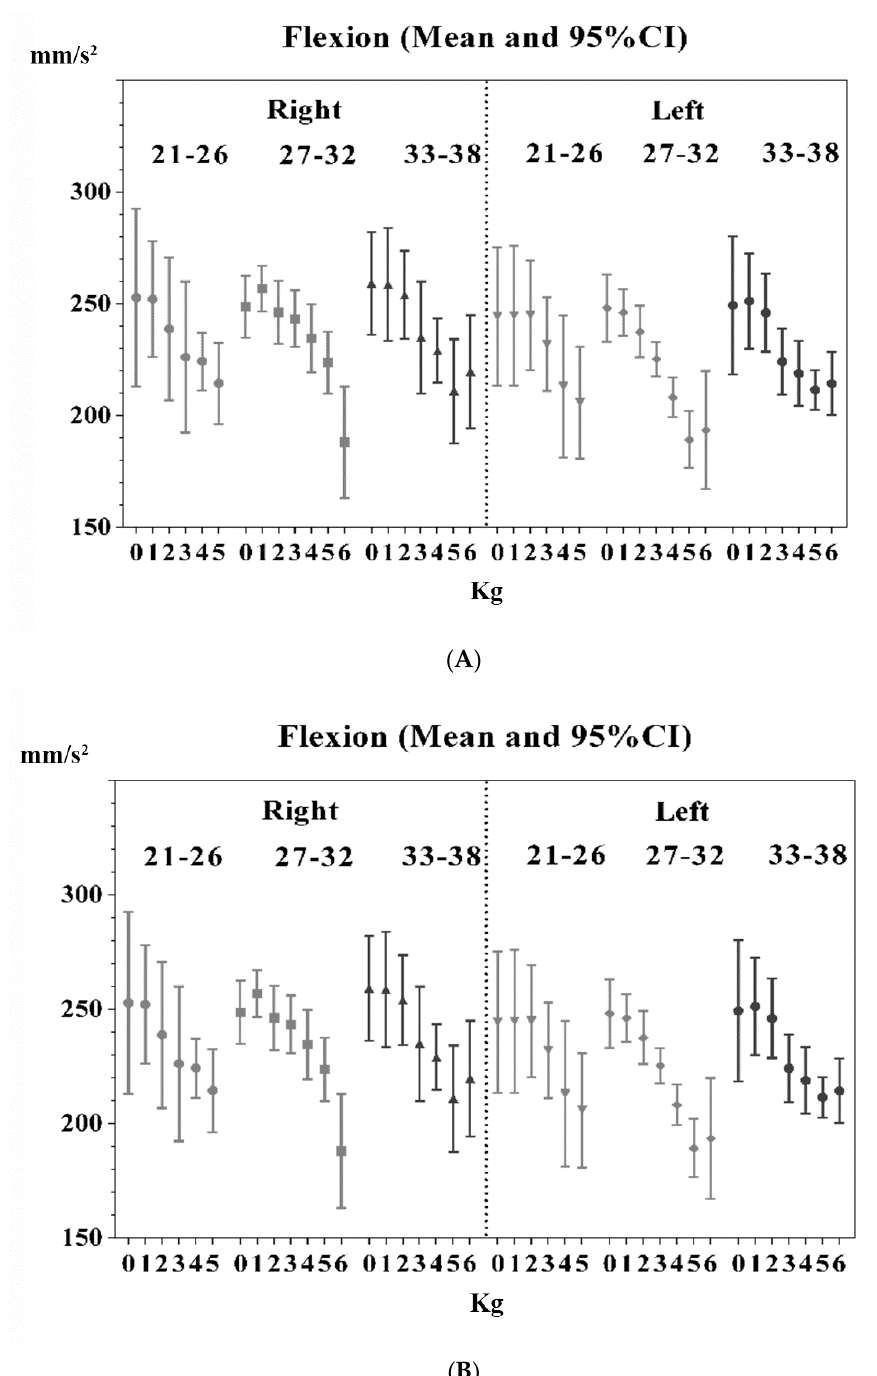
Figure 3. ( A ): Speed–weight relationship for the movement of flexion in males . ( B ): Speed–weight relationship for the push-up movement in women .